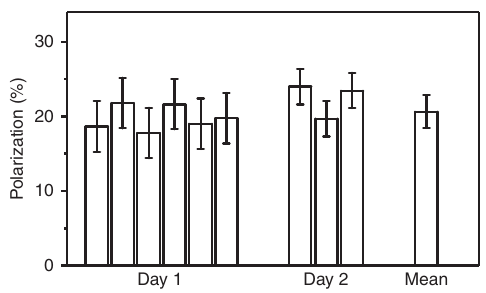
Figure 4 | SAMBADENA reproducibility: A mean polarization of P ¼ (21 ± 2) % was achieved in nine experiments on 2 days. Error bars correspond to the s.d. of the respective day or, in case of the mean, all experiments (reaction temperature T E 80 (cid:2) C, hydrogenation time t h ¼ 4s, concentration of substrate c HEP ¼ 5.54mM).